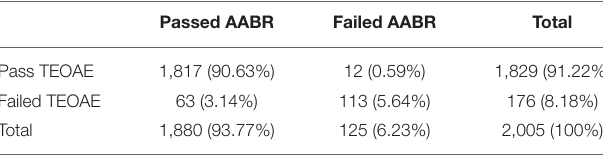
TABLE 2 | The pass and failure rates (n/%) of first screening in 2005 neonates during the first screening.